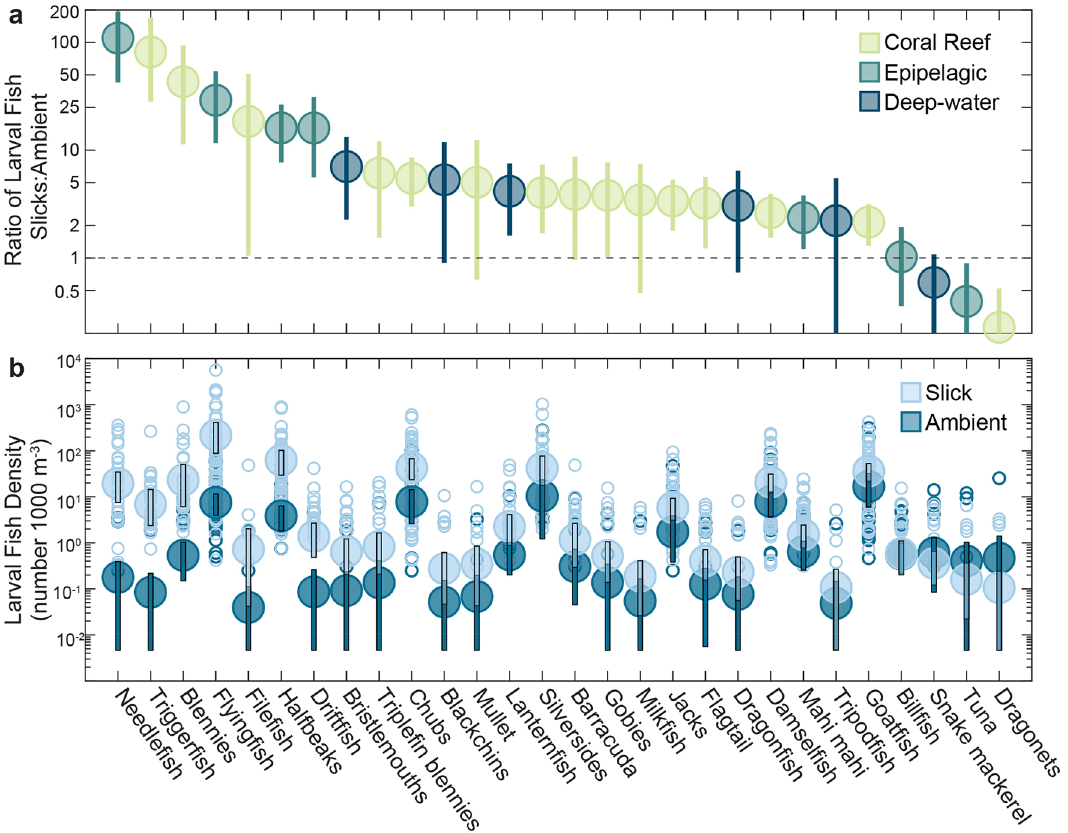
Figure 5. Accumulation ratios and densities of larval fish families in surface slicks compared to ambient waters. ( a ) Ratio of mean density in slicks to mean density in ambient water ± 95% bootstrap intervals for larval fish families from three natal habitats (Coral Reefs, Epipelagic and Deep-water). The dashed line at Y = 1 indicates equal densities in both habitats. Five additional reef fish families: pufferfishes (Tetraodontidae), cardinalfishes (Apogonidae), frogfishes (Antennariidae), squirrelfishes (Holocentridae), and surf sardines (Isonidae) that were found exclusively in slicks were excluded from the plot due to undefined ratios. ( b ) Mean (± 95% bootstrap intervals) densities of larval fish families from three natal habitats (Coral Reef, Epipelagic and Deep-water) in slicks (light blue) compared to ambient waters (dark blue). Open circles indicate individual neuston tow samples in slicks ( n = 80) and ambient waters ( n = (Fig. 1b) up to this region (see “Methods”—“Remote sensing” and Gove & Whitney et al. 34 ). We estimate that surface slicks occupy 8.3 ± 2.4% (mean ± SD) of all nearshore (≤ 6.5 km) ocean surface habitat 34 but contain 21.9 ± 2.4% of all neustonic larval invertebrates, 26.5 ± 2.8% of surface-dwelling zooplankton, and 39.1 ± 3.5% of neustonic larval fish (see “Methods”—“Scaling estimates”). We found that the estimated percentage that occurs in the top 1 m of slicks across this region increases with life stage, starting with fish eggs (22.9 ± 2.5%), and increasing from early larval stages < 10 mm (38.5 ± 3.5%) through late-larval stages ≥ 10 mm (46.3 ± 3.7%) then up to larger pelagic juveniles ≥ 30 mm (90.9 ± 1.3%), which were almost exclusively found in slicks. We also estimate that slicks contained 75.4 ± 2.9% of floating organic debris and 95.7 ± 0.6% of floating plastic debris, which combined represents 86.4 ± 1.9% of all floating debris in our study area.